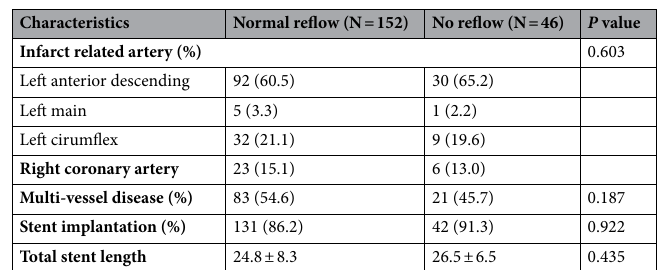
Table 2. Angiography and procedural features of STEMI patients.